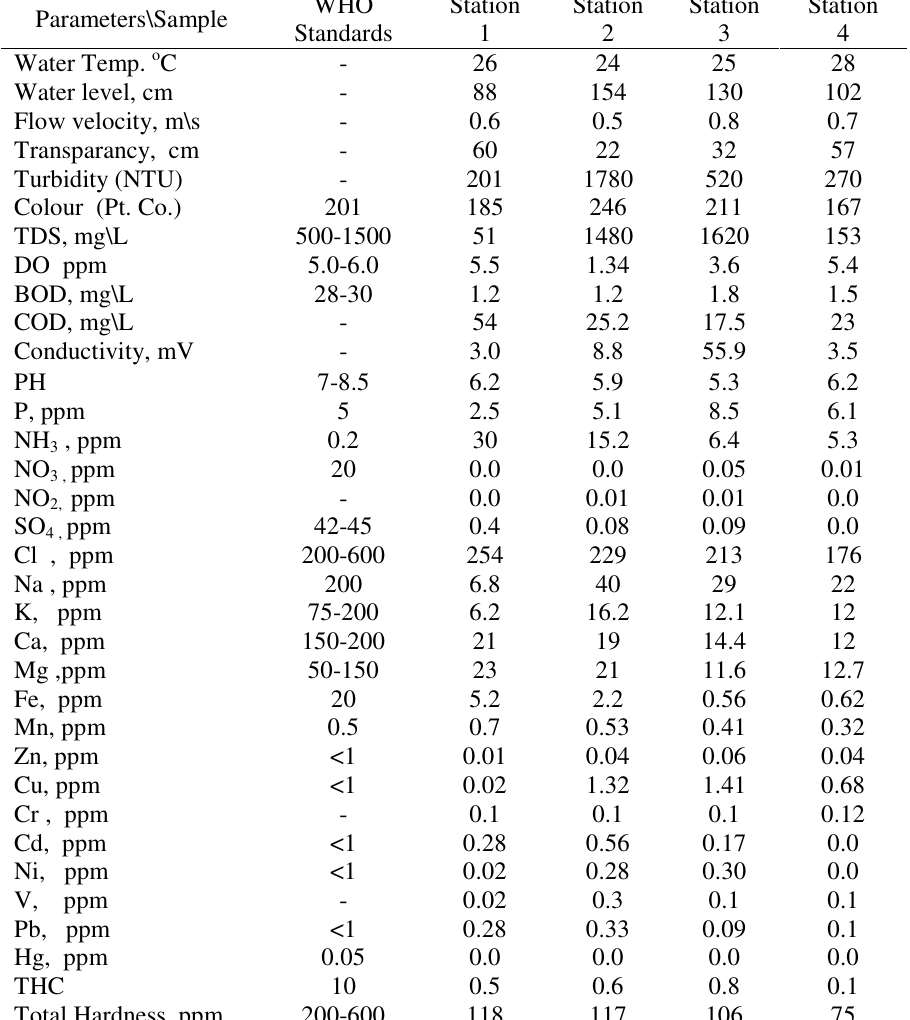
Table 1 . Water quality parameters of water samples collected from 4 Stations of Cauvery